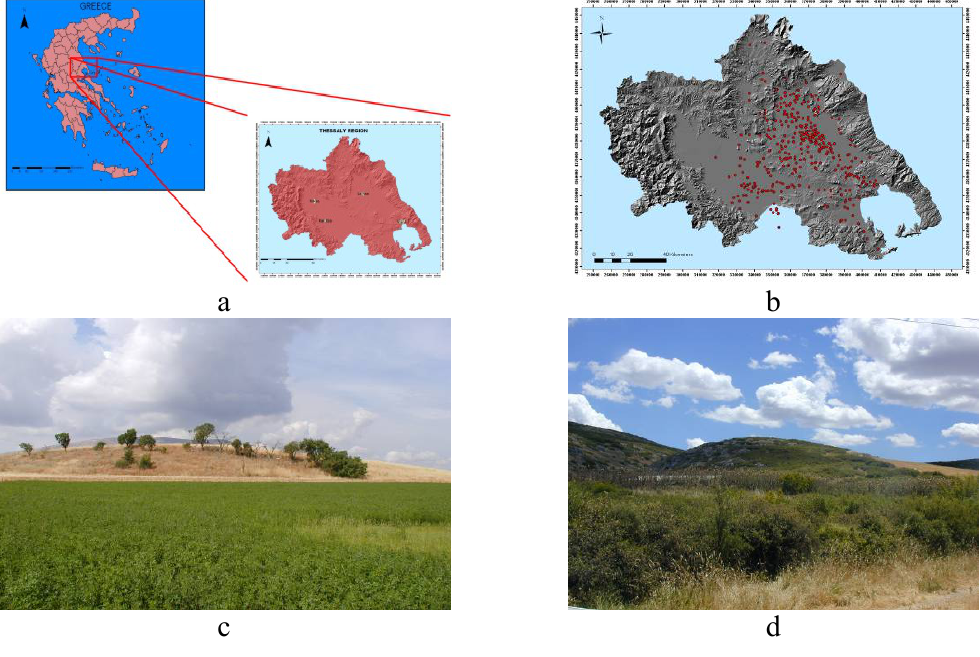
Figure 1. The region of Thessaly is located at the center of the mainland of Greece (Top Left). Most of the magoules are distributed within the limits of the plains of Larisa and Karditsa (Top Right). Details of the magoula of Kastro (Bottom Left). Details of the magoula of Kalo Nero (Bottom